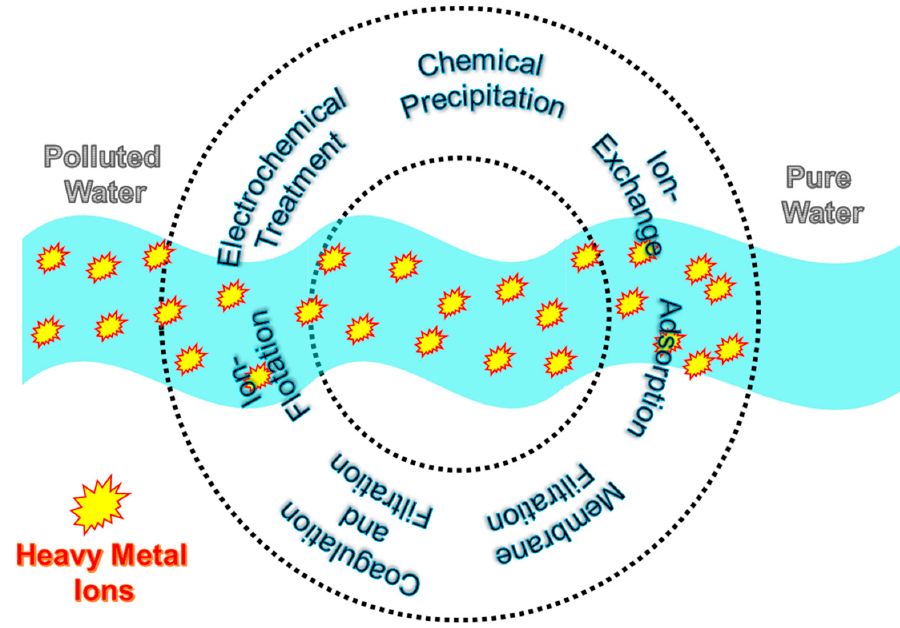
Figure 2. Different methods used to purify heavy metal ions in polluted water.